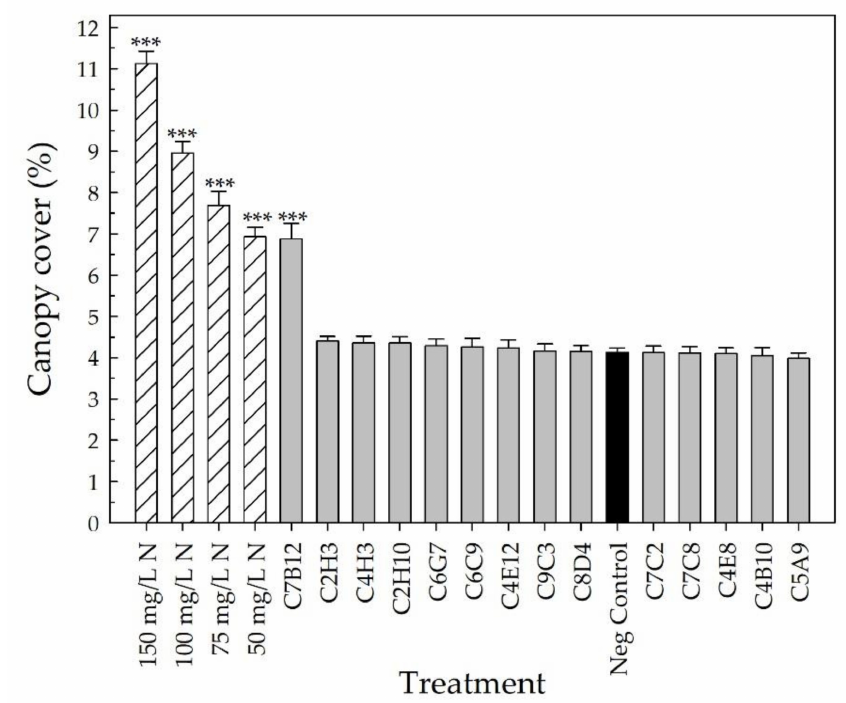
Figure 6. Percentage canopy cover of individual Petunia × hybrida ‘Picobella Blue’ in the greenhouse validation trial treated with the 14 bacterial strains selected from the high-throughput greenhouse trials ( n = 12). Plants were measured at harvest after flowers and buds were removed. All plants treated with bacteria were fertilized with 25 mg L − 1 N (gray bars). The black bar represents the negative control (no bacterial treatment) fertilized with 25 mg L − 1 N, and the white bars with slanted lines represent the four positive controls (no bacterial treatment) fertilized with either 50, 75, 100, or 150 mg L − 1 N. The treatments were compared to the negative control using Dunnett’s comparison. Significance is represented by *** at p ≤ 0.001. Bars represent the mean, and error bars denote standard